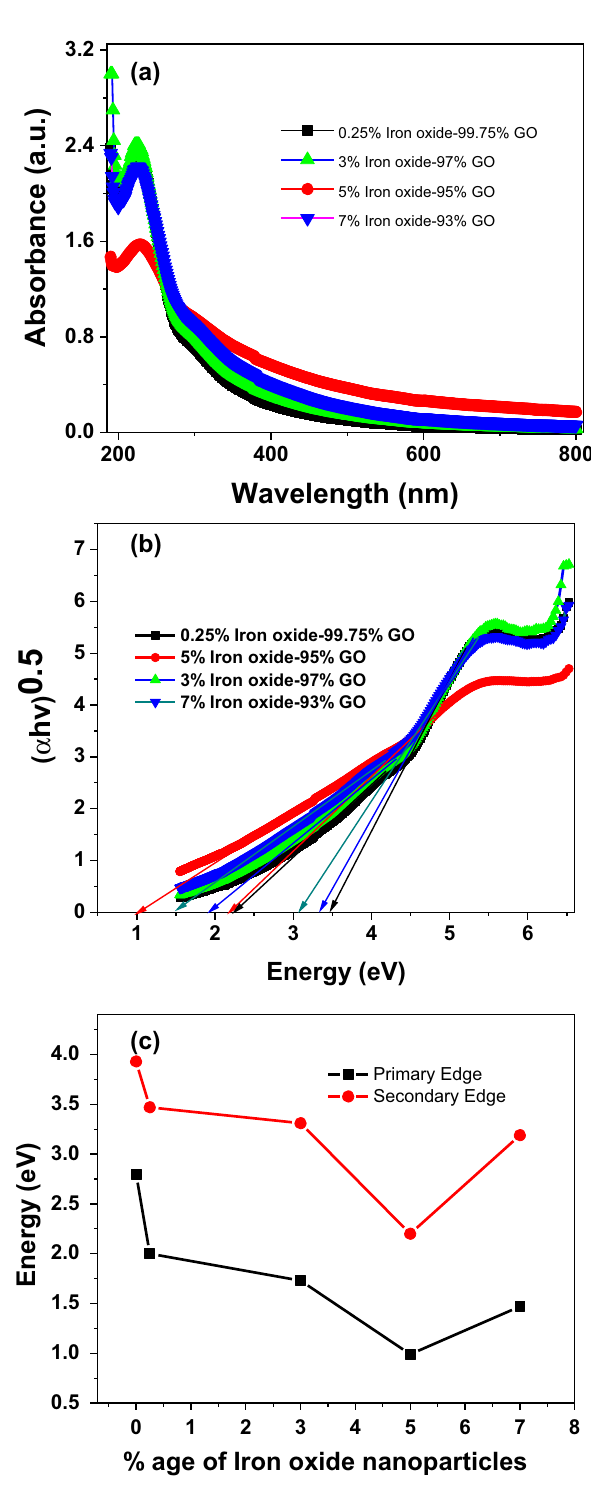
Figure 11. ( a ) Absorption spectra of composite samples ( b ) Tauc plot of nanocomposite samples ( c ) Band gap variations in nanocomposite samples with varying iron oxide